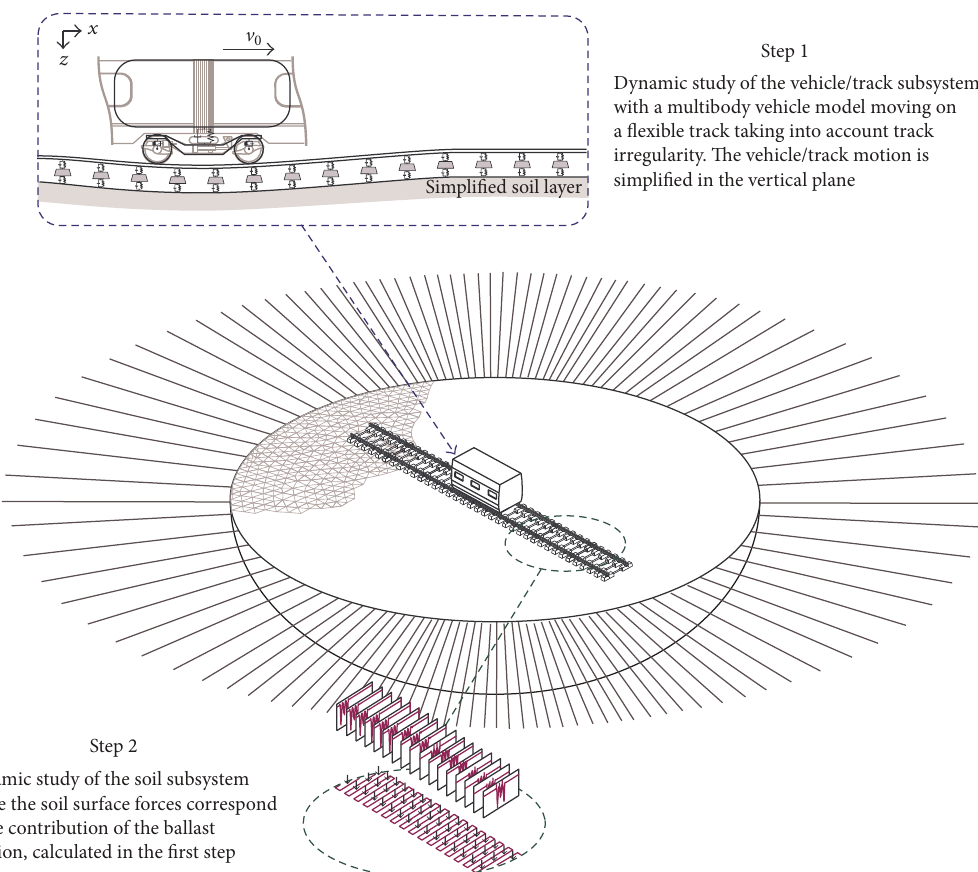
Figure 1: Vehicle/track/soil model, working in two